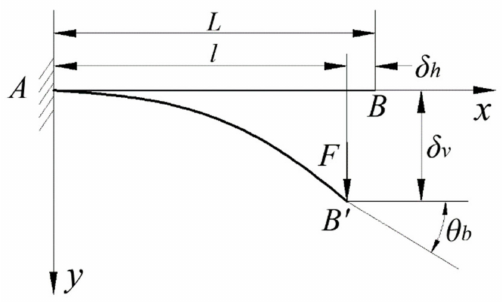
Figure 1. Large deformation of beam under point load at free